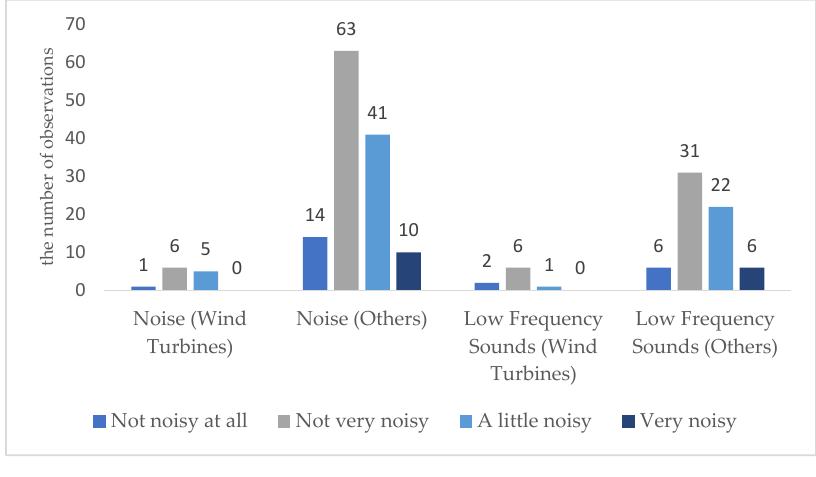
Figure 8. Evaluation of sounds around places of residence.